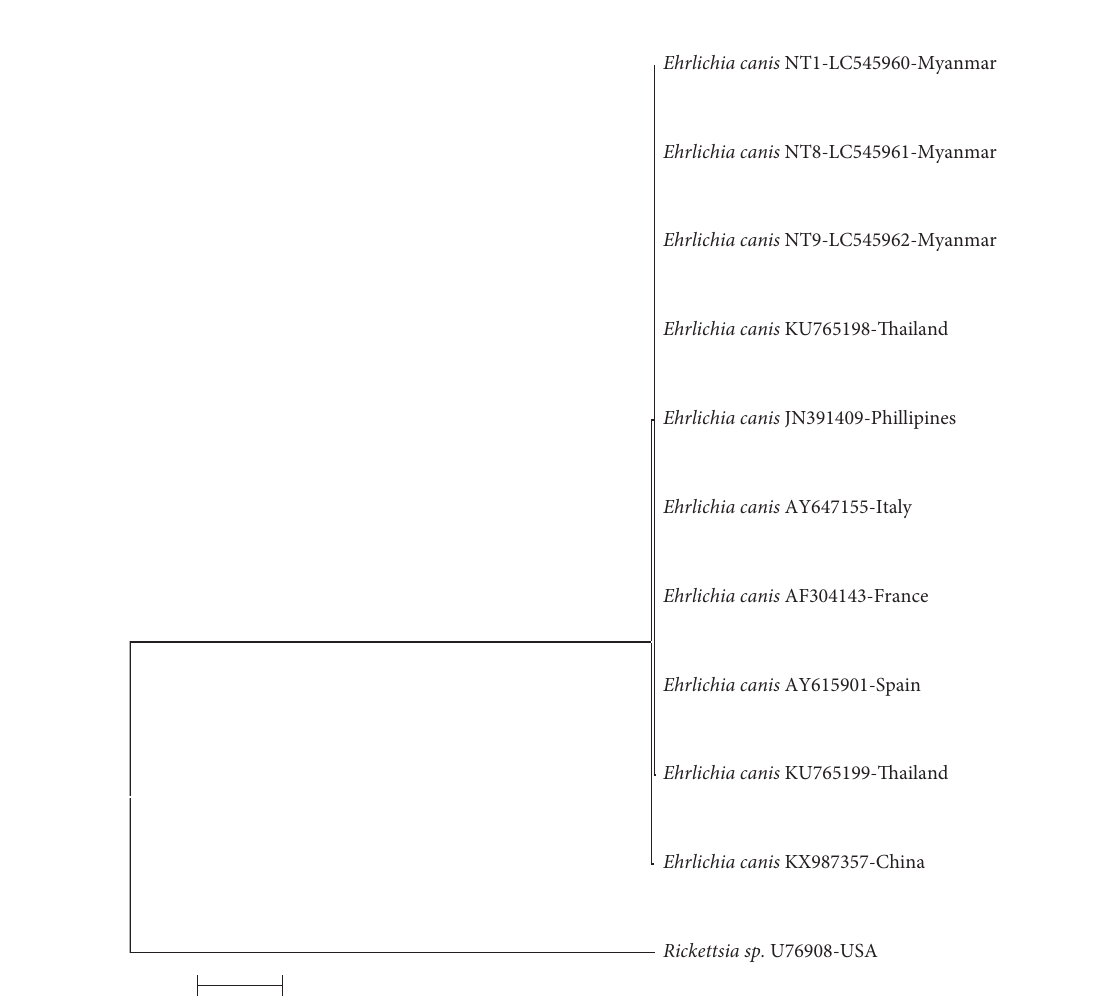
Figure 3: Phylogenetic tree based on the Ehrlichia gltA sequence. Sequences from the Ehrlichia genera were compared with the neighbor- joining method with distance matrix calculation by Kumar-two parameters, operated by MEGA software (Version 7), using Rickettsia sp. as the outgroup. Scale bar indicates the number of mutations per sequence position. The numbers at the nodes represent the percentage of 1000 bootstrap